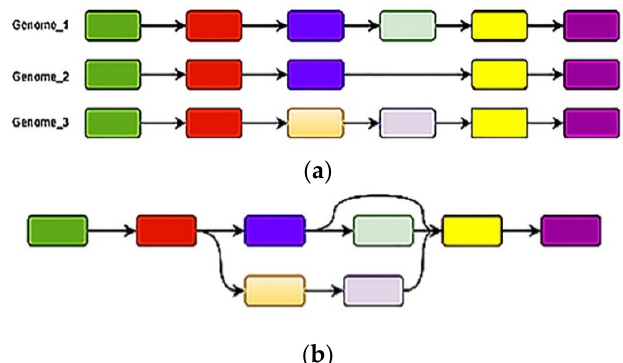
Figure 3. ( a ) tetraploid genome ( b ) assembly graph.